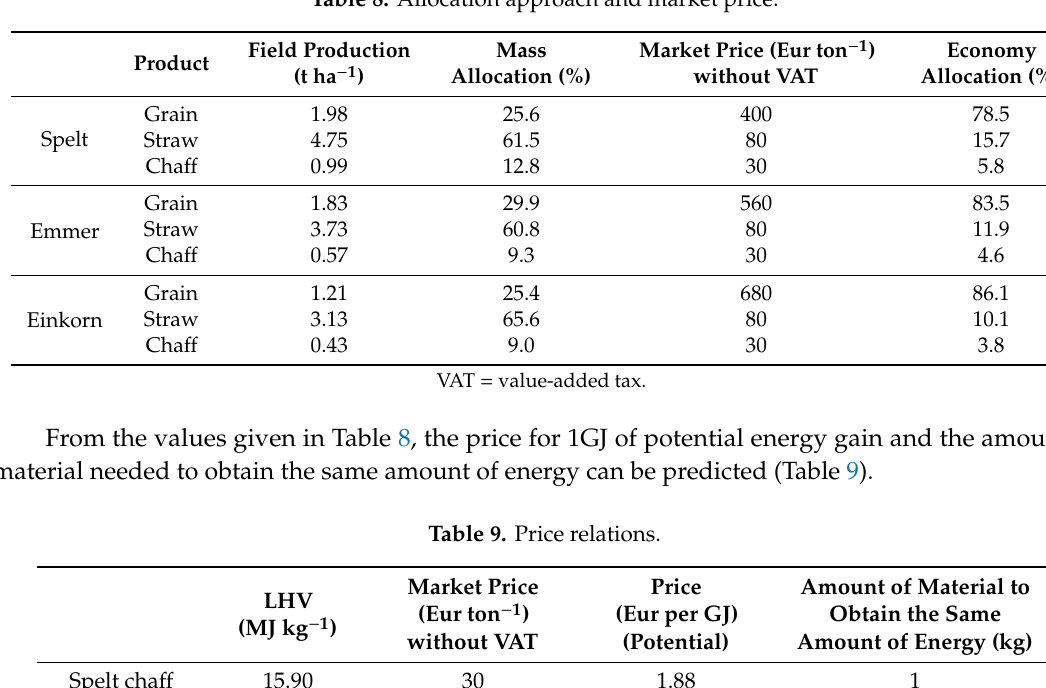
Table 8. Allocation approach and market price.